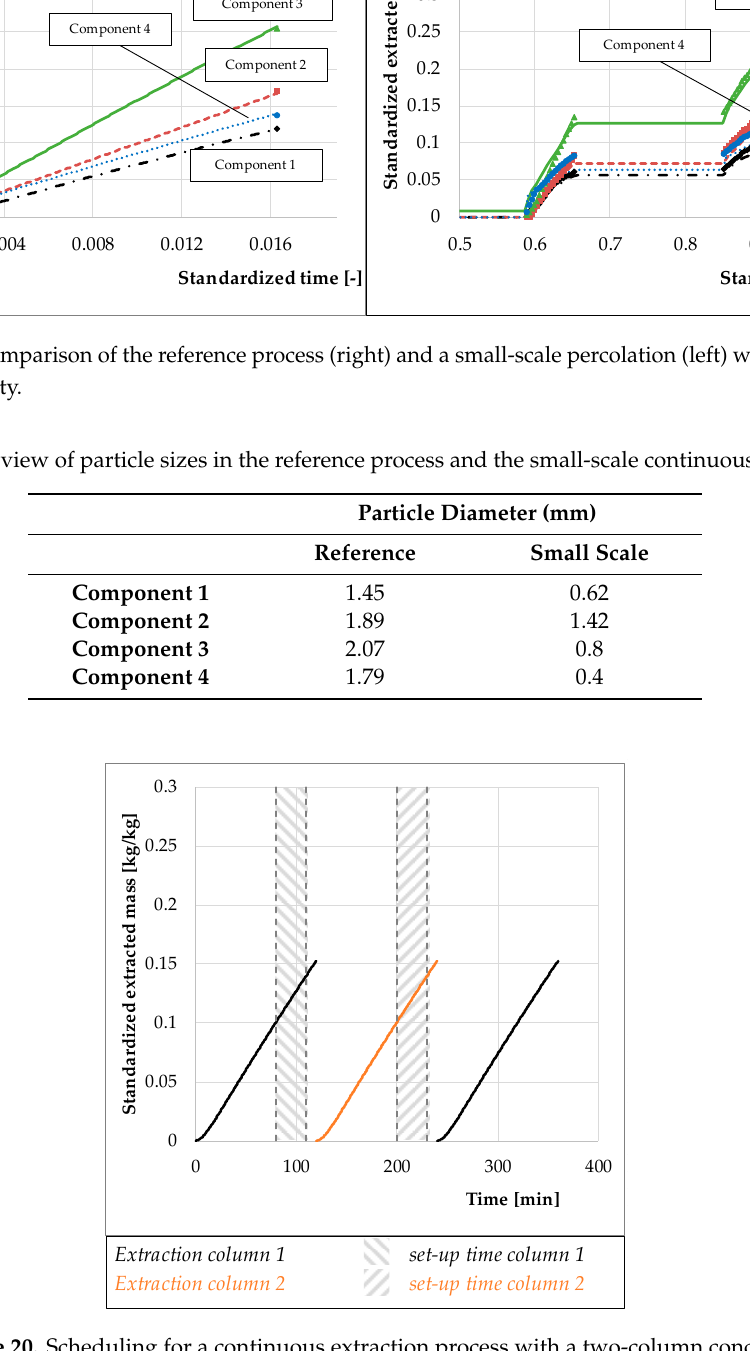
Figure 20. Scheduling for a continuous extraction process with a two-column concept.